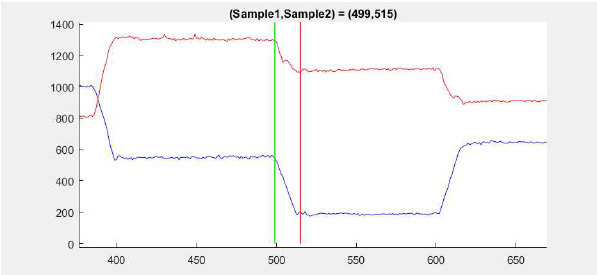
Figure 17 . Scatter plot for dataset 2.3 between sample 499 (green square) and sample 515 (red square). The position plot shows a jag in the y-signal, which could potentially mislead an algorithm, see fig. 18.